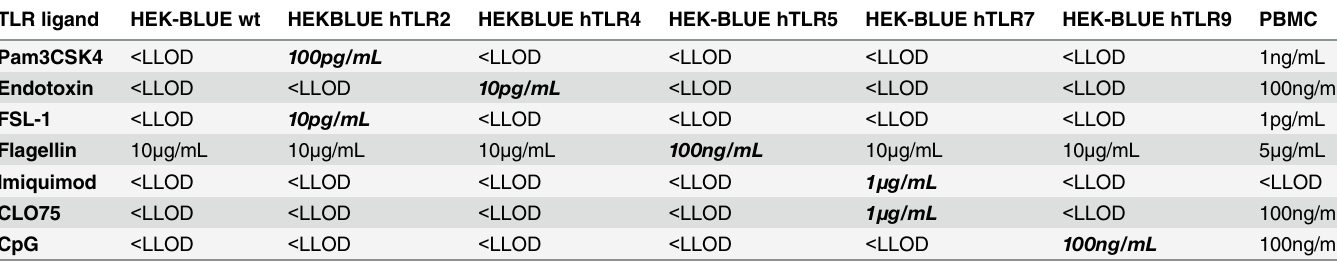
Table 1. Specificity of hTLR transfected HEK-BLUE cells towards their own